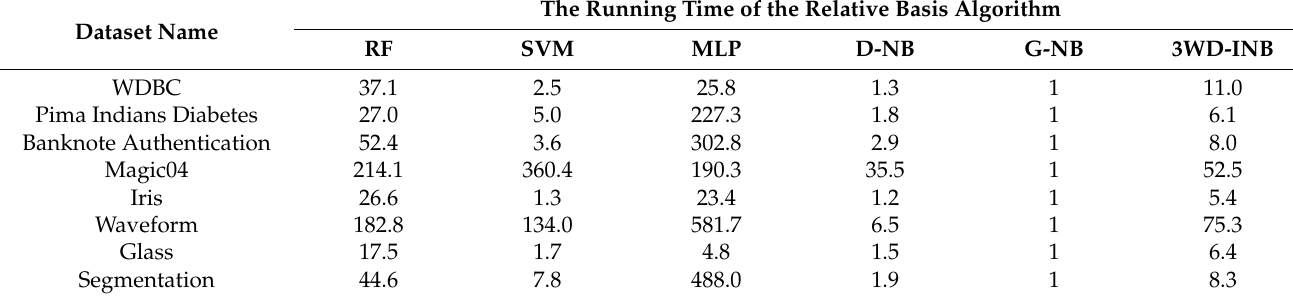
Table 11. Algorithm time consumption under continuous